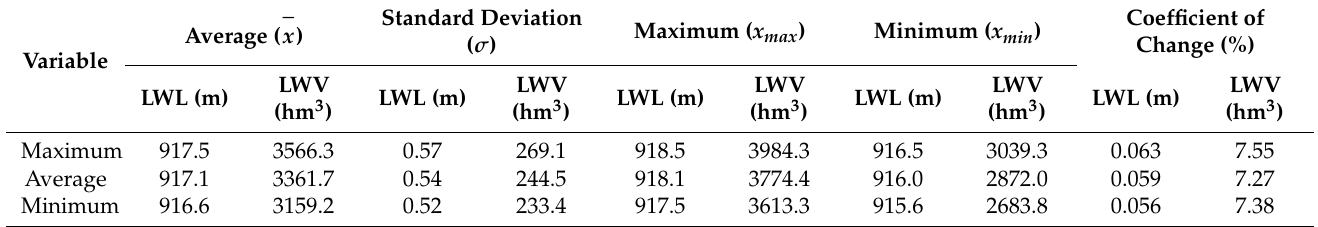
Table 2. Statistical variables of the annual LWL and LWV values of Lake